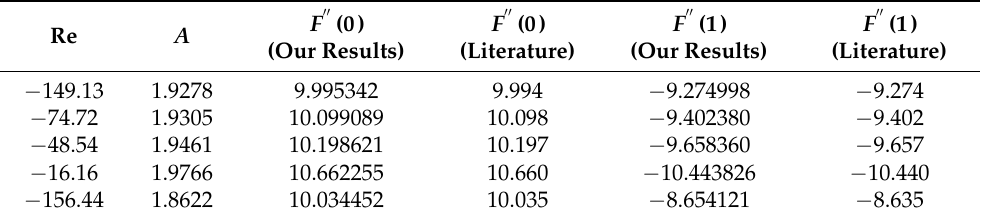
Table 1. Comparison of our results with the literature for the classical Newtonian fluid proposed by Shrestha and Terrill [53].